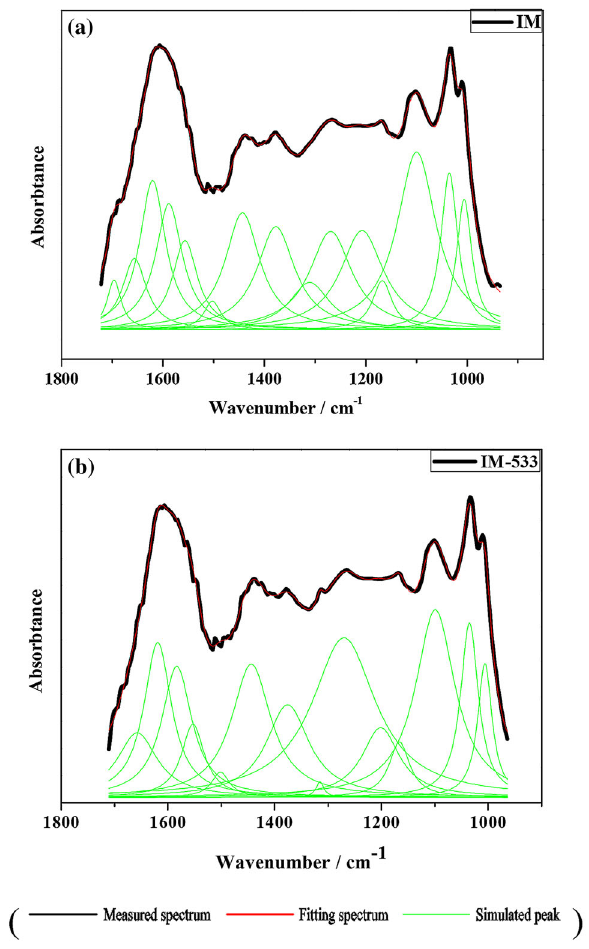
Fig. 8 Fitted FTIR spectra of the oxygen functional group in IM- Raw and IM-533 (Black line is measured spectrum, red line is fitting spectrum, green line is simulated